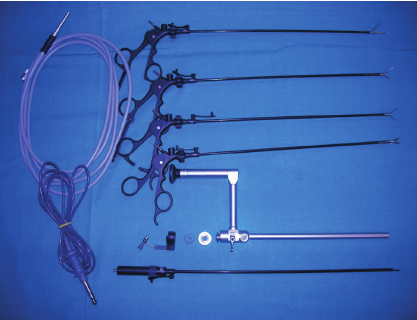
Figure 1: The instrumentation for the TULAA appendectomy: cautery hook, operative scope, and long graspers.